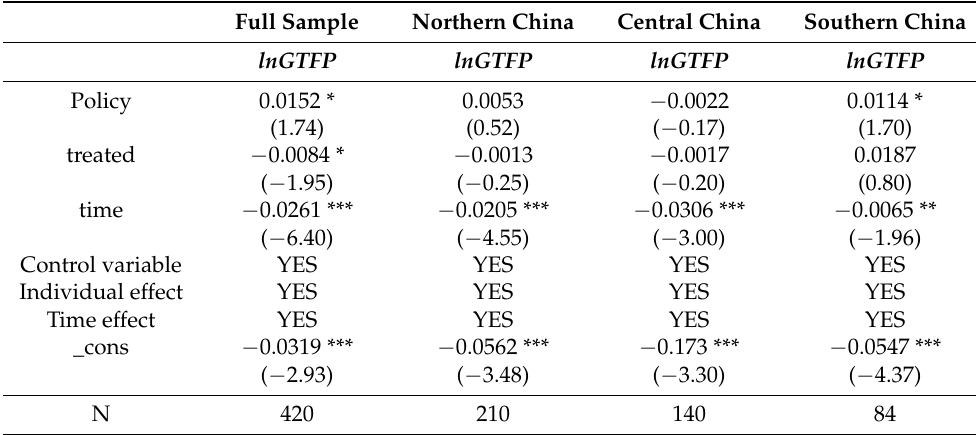
Table 7. Regression results of the full sample and regional samples in China. Full Sample Northern China Central China Southern